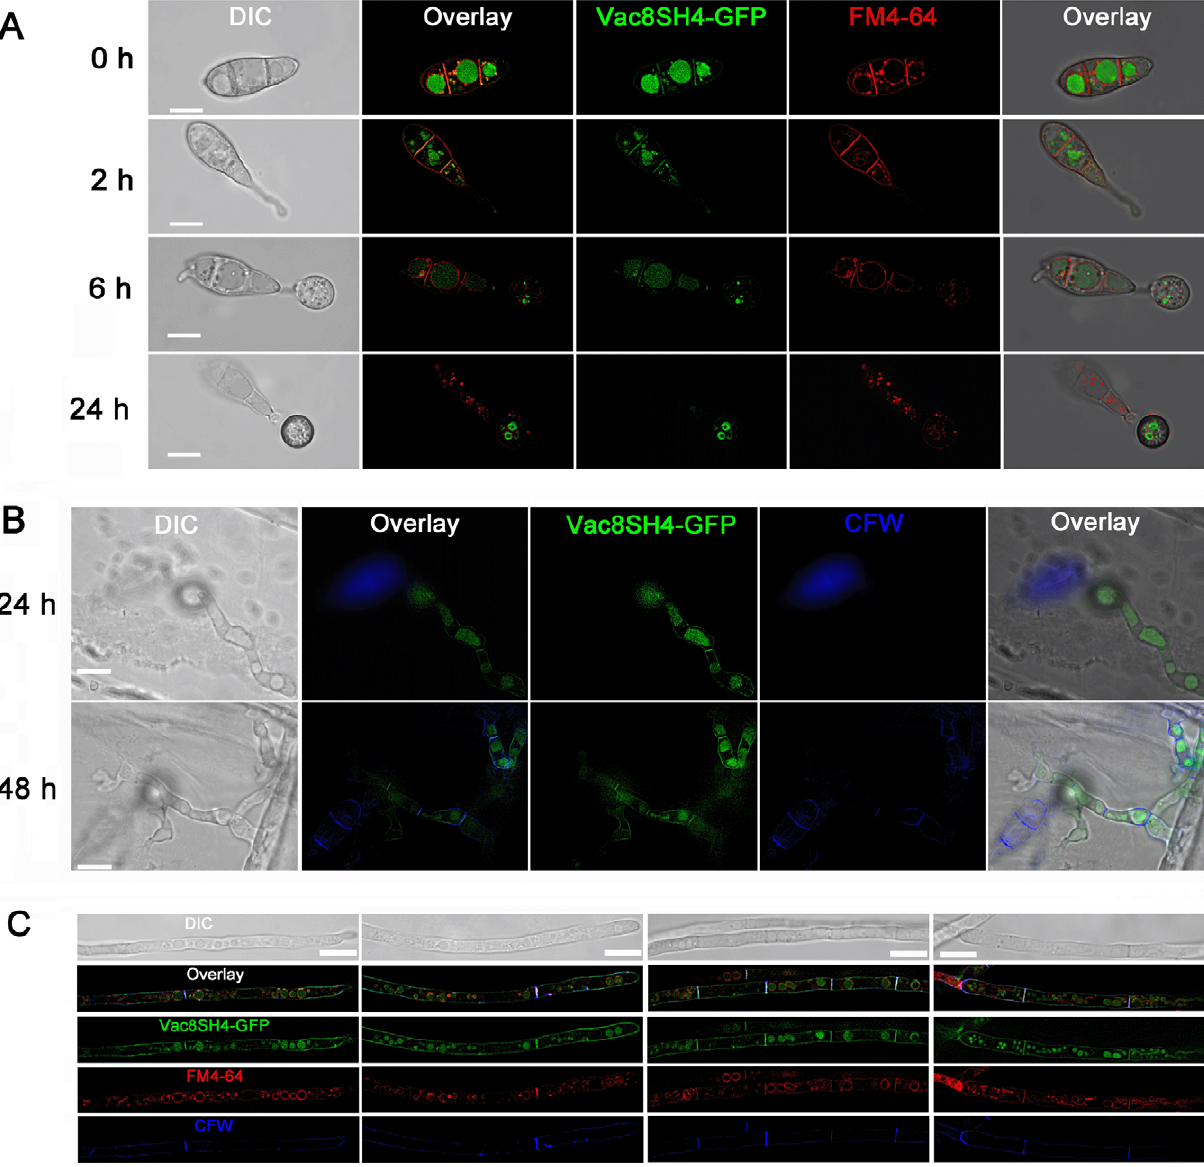
(Figure 9B). Re-introduction of the MoTSC13:GFP fusion construct into a D Motsc13 mutant restored normal vegetative growth, penetration peg formation and pathogenicity on rice leaves (Figure 9A and B; Figure S8 A). We conclude that MoTsc13 is involved in penetration hypha development during plant infection.